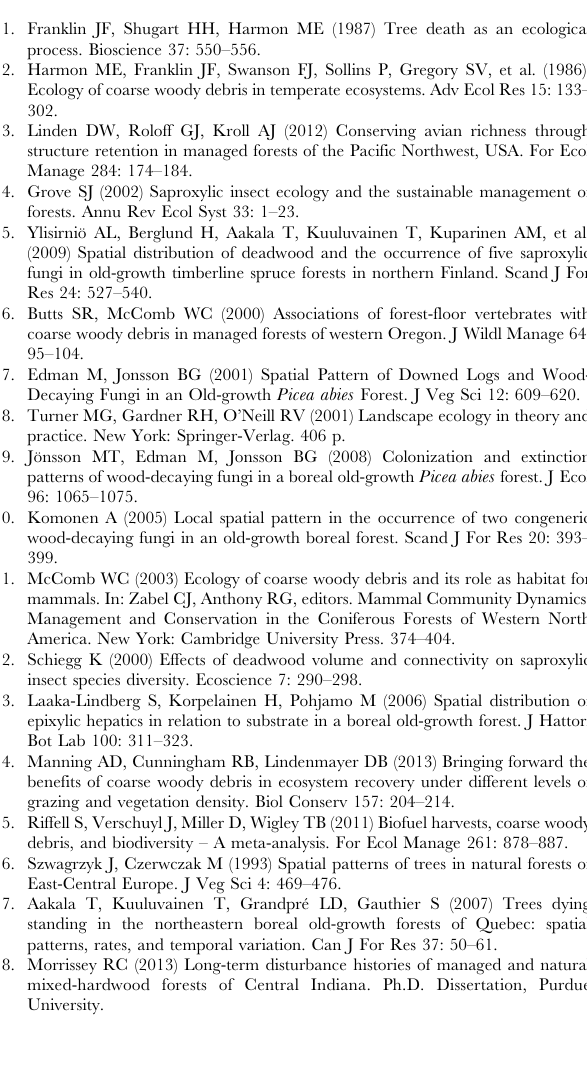
Table S2 Downed deadwood (DDW) data. (CSV) Table S3 Standing deadwood (SDW) data.